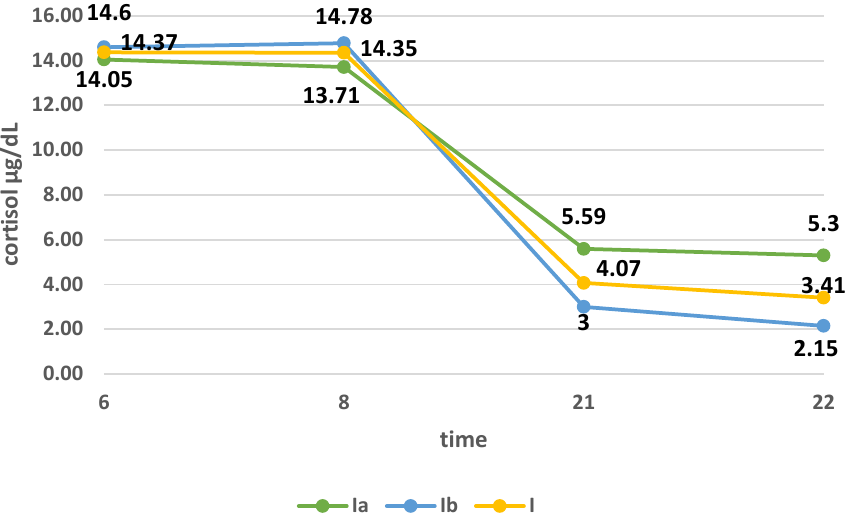
Figure 2. The diurnal profile of the secretion of cortisol in the study group and in groups Ia and Ib. The mean cortisol concentration in the control group was 11.42 ± 3.51 µ g/dL,